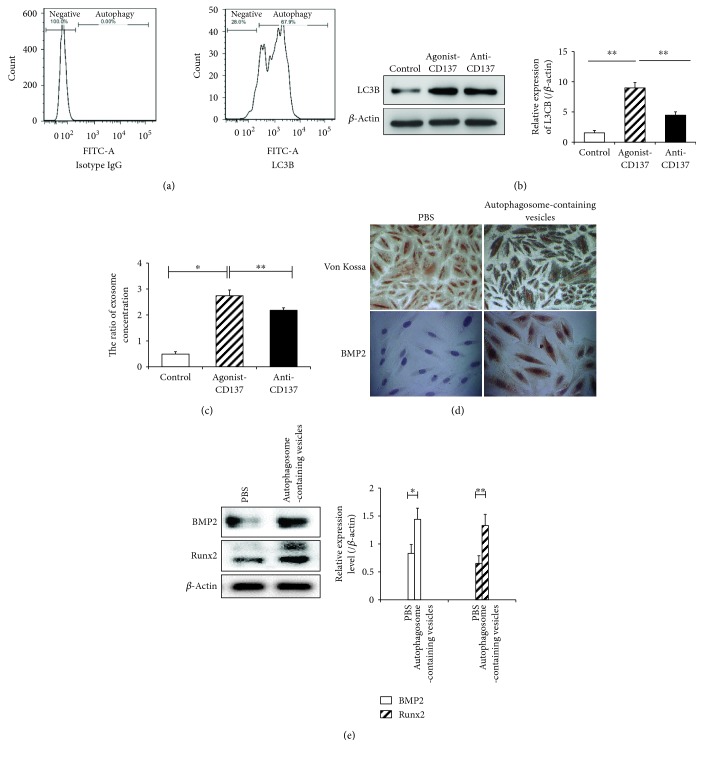
Autophagosome-containing vesicles secreted by VSMCs stimulated by CD137 signaling could result in calcification. (a) Autophagosome-containing vesicle in agonist-CD137 group was collected and flow cytometry was used to detect the expression of LC3B of the vesicle. (b) Image showing the protein expression of LC3B in autophagosome-containing vesicle collected in each group. (c) BCA protein assay evaluated the concentration of autophagosome-containing vesicle secreted by VSMCs of each group. (d) VSMCs were cultured with PBS and agonist-CD137 group originated autophagosome-containing vesicle. Von Kossa staining was applied to indicate the calcification, and the expression of BMP2 in treated VSMCs was detected by immunohistochemistry. (e) Western blot was used to detect calcification markers of VSMCs extracted lysis. Data are expressed as the mean ± SEM of three independent experiments. ∗ refers to P < 0.05; ∗∗ refers to P < 0.01.